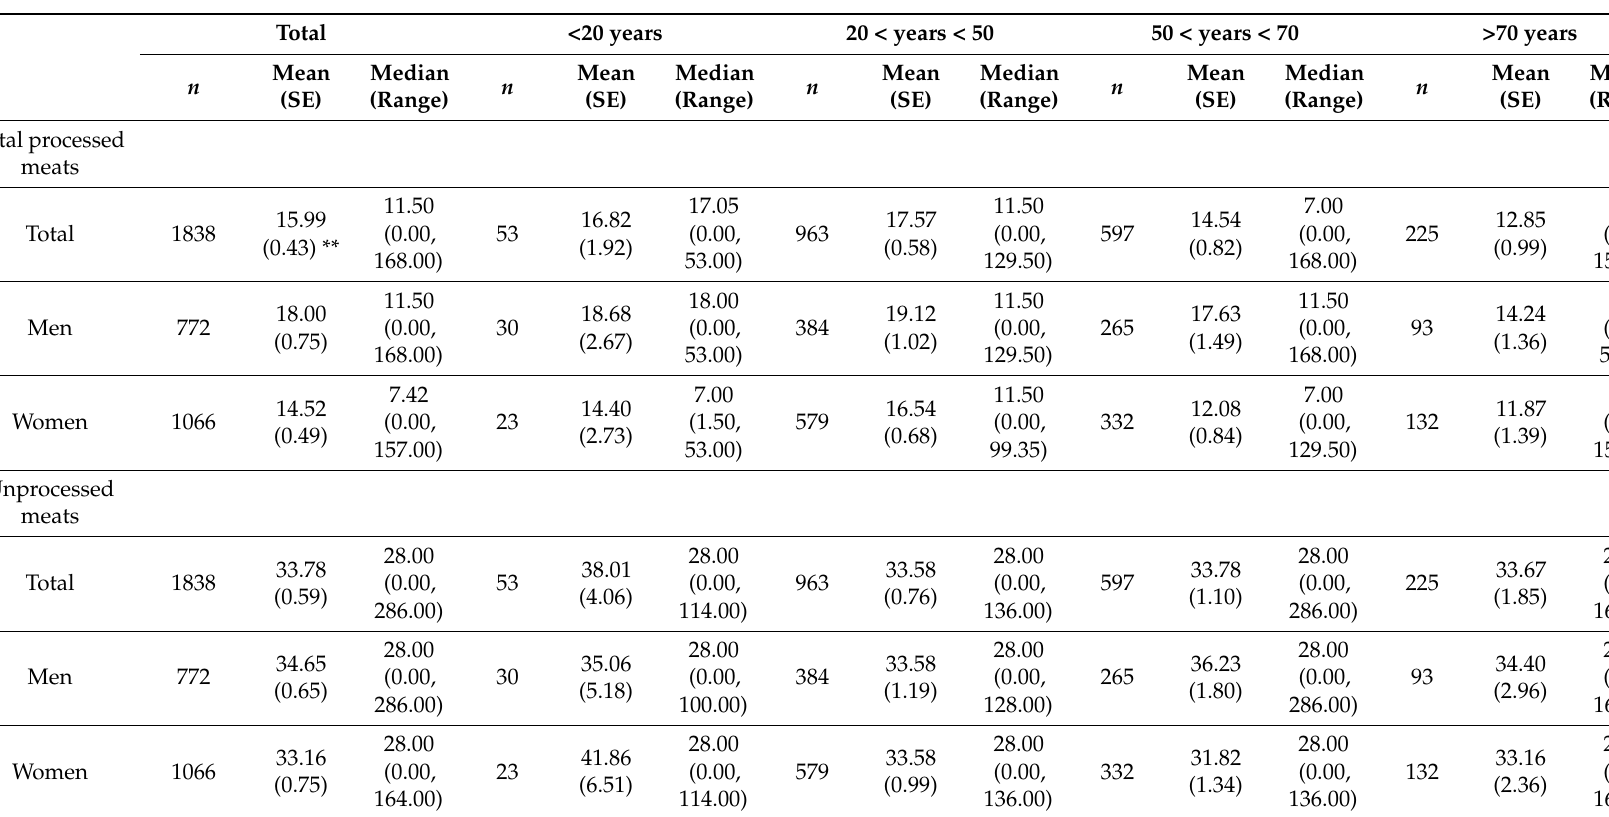
Table 2. Total, sex, and age group-specific consumption of animal food groups in the study participants of the MEAL study ( n = 1838). * denotes p < 0.05, ** denotes p <